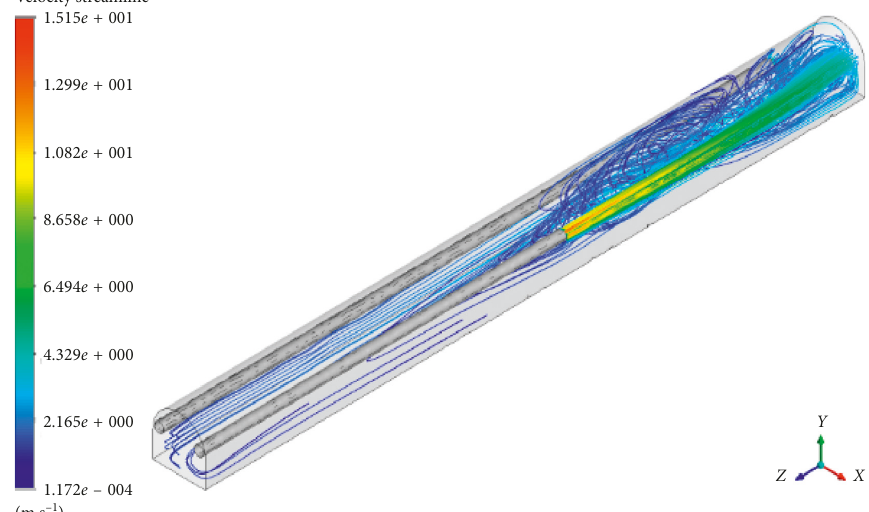
Figure 4: 3D diagram of airflow